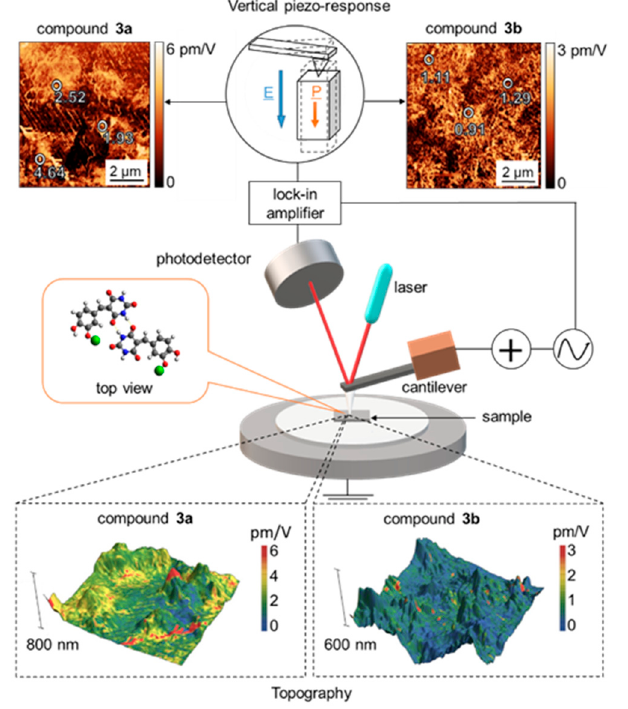
Figure 3. Surface topography and overlaid vertical piezoelectric responses of compounds 3a and 3b exposed to alternating voltage from PFM tip (probe spring constant is 10–12 N/m, working frequency is 20 kHz).